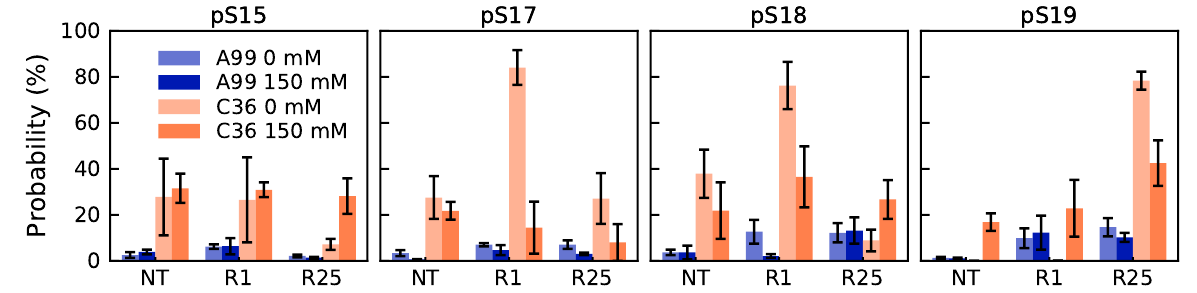
Figure 9. Probability of possible salt bridge interactions for the phosphorylated residues with the N-terminus (NT) and positively charged residues in bCPP, simulated with the two different force fields in the presence of 0 mM or 150 mM NaCl. Error bars corresponds to errors calculated by block